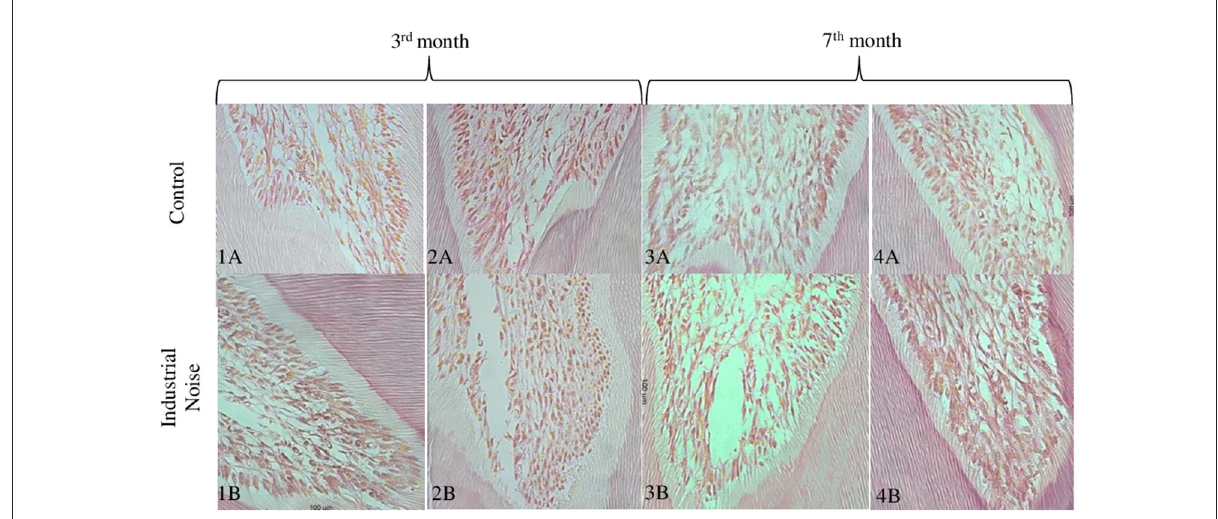
FIGURE4 Microphotographs of cross-sections of Wistar rat teeth, where it is possible to observe the cells in the coronary portion of the dental pulp. Representative samples from the 3rd and 7th months of control (A) , and from the 3rd and 7th months of exposure (B) (HE, 40X).